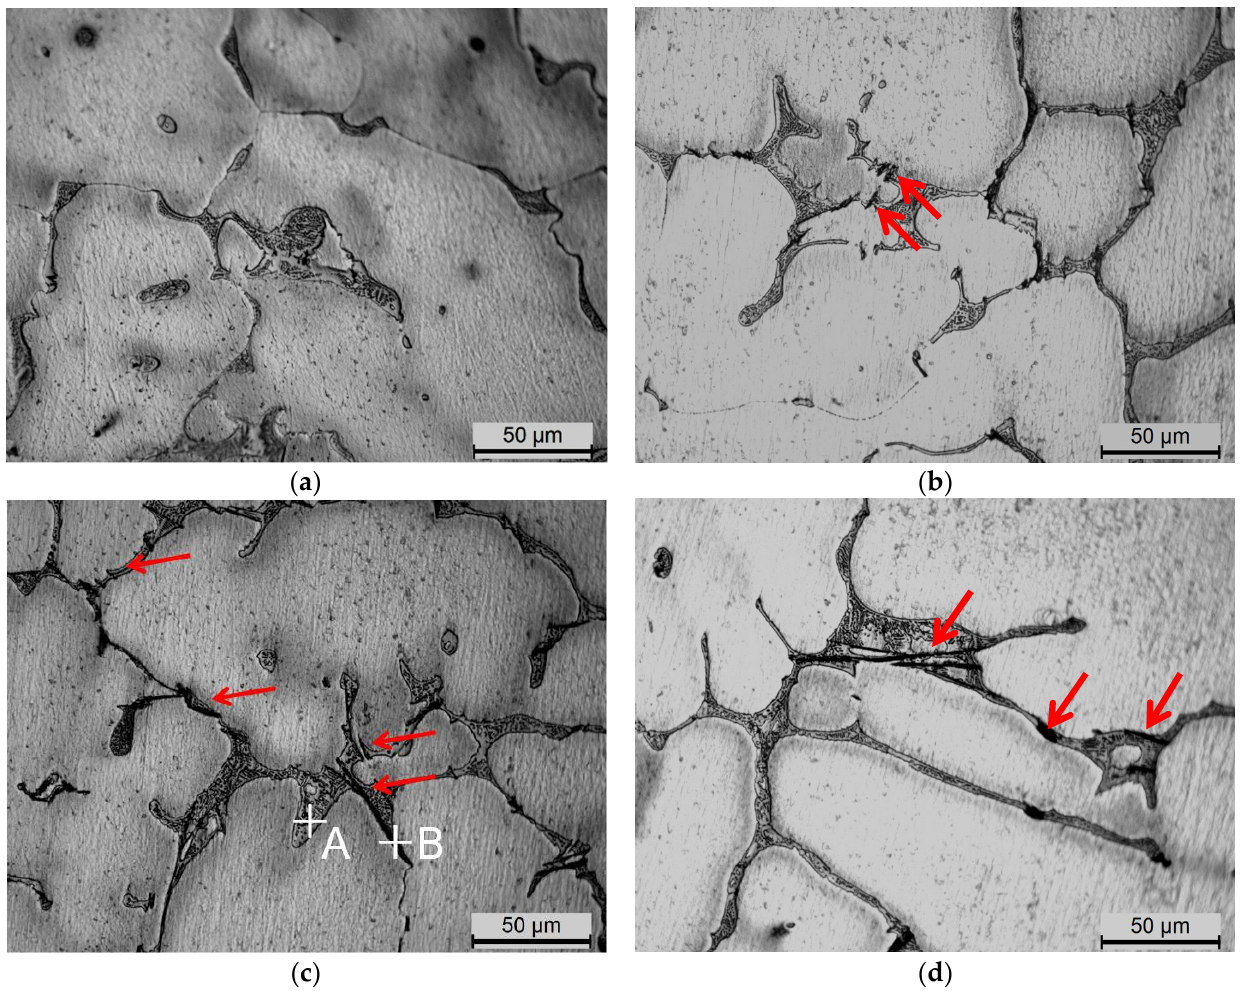
Figure 2. Microstructures of the as-cast alloys with different Fe contents: ( a ) 0.03 wt.%; ( b ) 0.10 wt.%; ( c ) 0.15 wt.%; and ( d ) 0.20 wt.%.